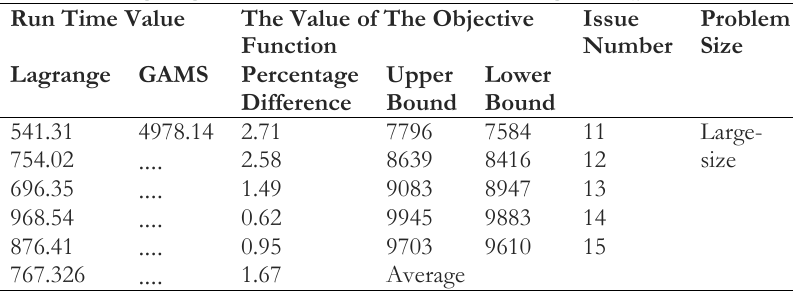
Table 2. Lagrange objective function values in Large-size problems.